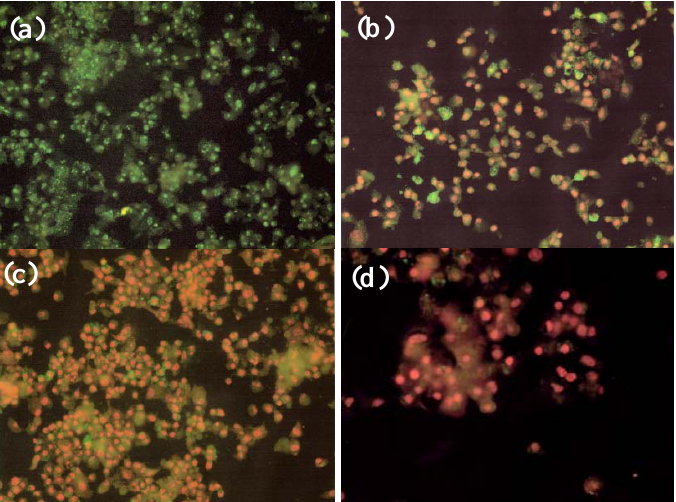
Figure 8. Effect of NM on HepG2 apoptosis: photomicrographs ( a ) Control, ( b )